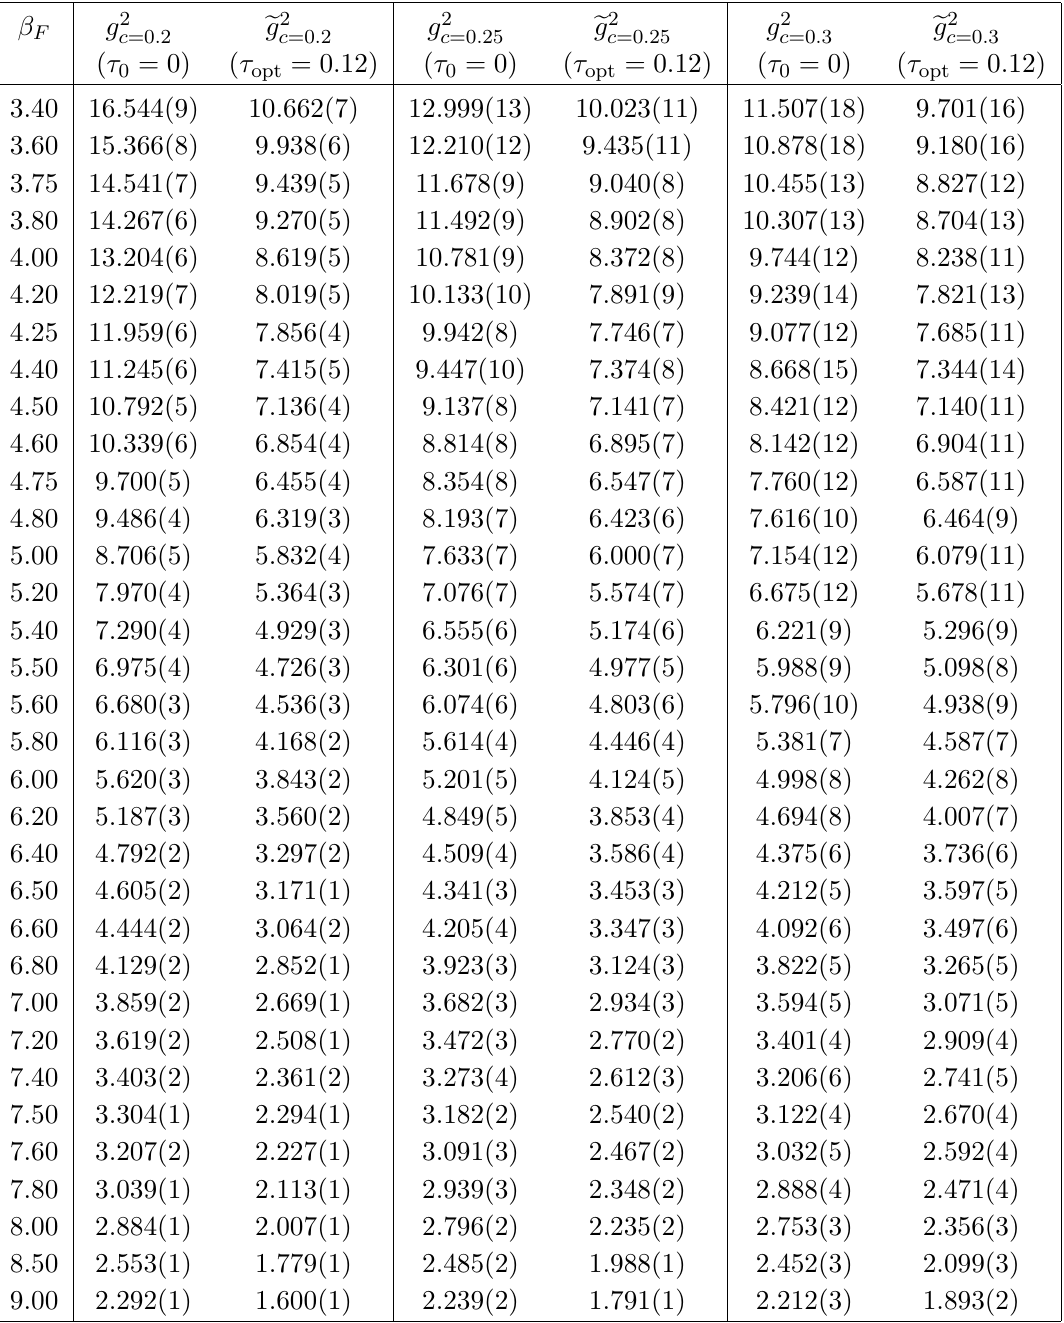
Table 15 . Renormalized gradient (cid:13)ow couplings based on the plaquette discretization of E ( t ) for the 12 4 lattice ensembles used in this work at three values of c = 0 : 2, 0.25 and 0.3, with both (cid:28) 0 = 0 and the optimal (cid:28) opt = 0 : 12 as in table